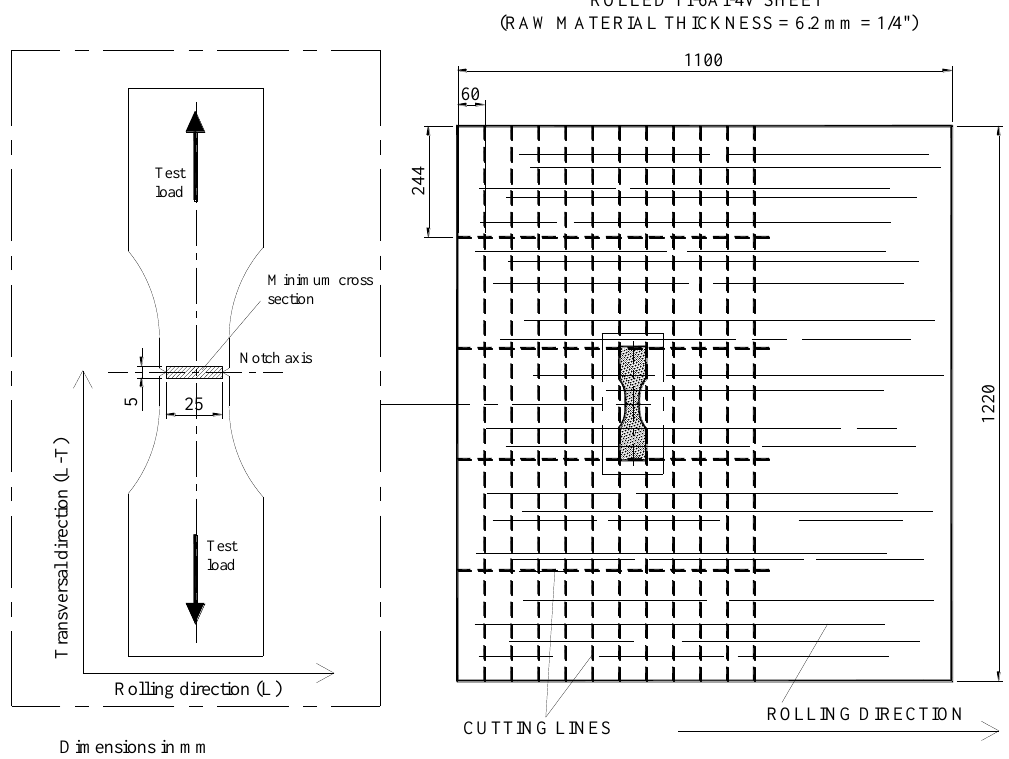
Figure 3. Sketch of the specimens’ orientation with respect to the parent Ti-6Al-4V plate rolling